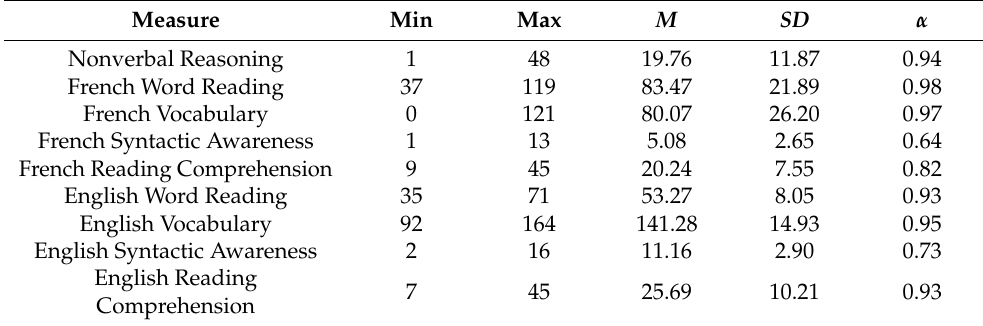
Table 1. Means, Standard Derivations (SDs), and Cronbach’s Alpha ( α ) of All Measures (n =